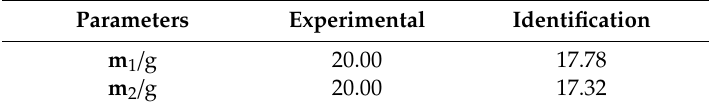
Table 8. The Identification Results of Accelerometer